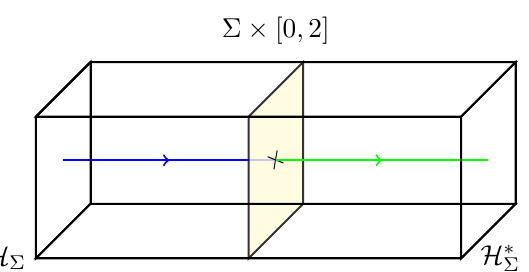
Figure 14 . A full RCFT includes a choice of chiral algebras and modular invariant. The modular invariant of the RCFT can be understood as a choice of interface inbetween the chiral halves in the associated 3d TFT. The Hilbert space of primaries of the form φ on the interface which turn a Wilson line of type i into a Wilson line of type j